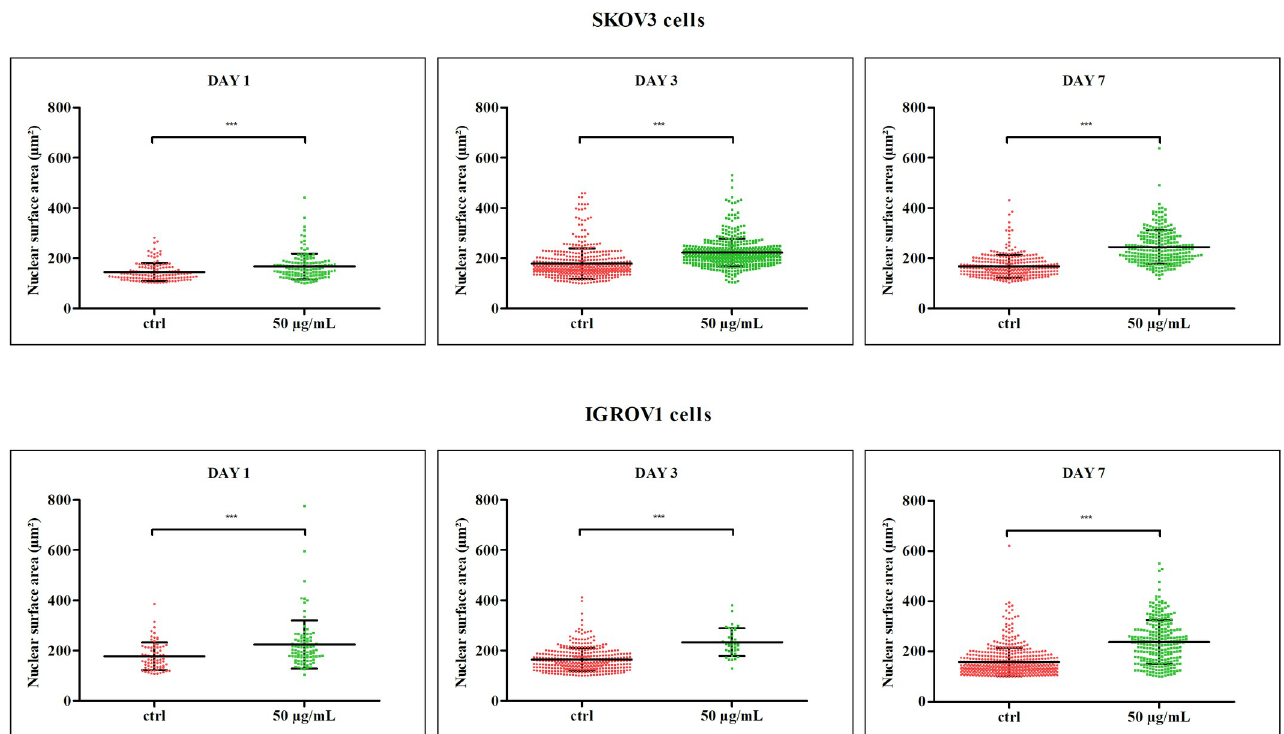
Fig 5. Analysis of the nuclear area. The average areas of the nuclei in μ m 2 after SRO-91 (50 μ g/ml) treatment of cancerous cells was quantified. P-values were calculated by the unpaired t-test ( ��� P <